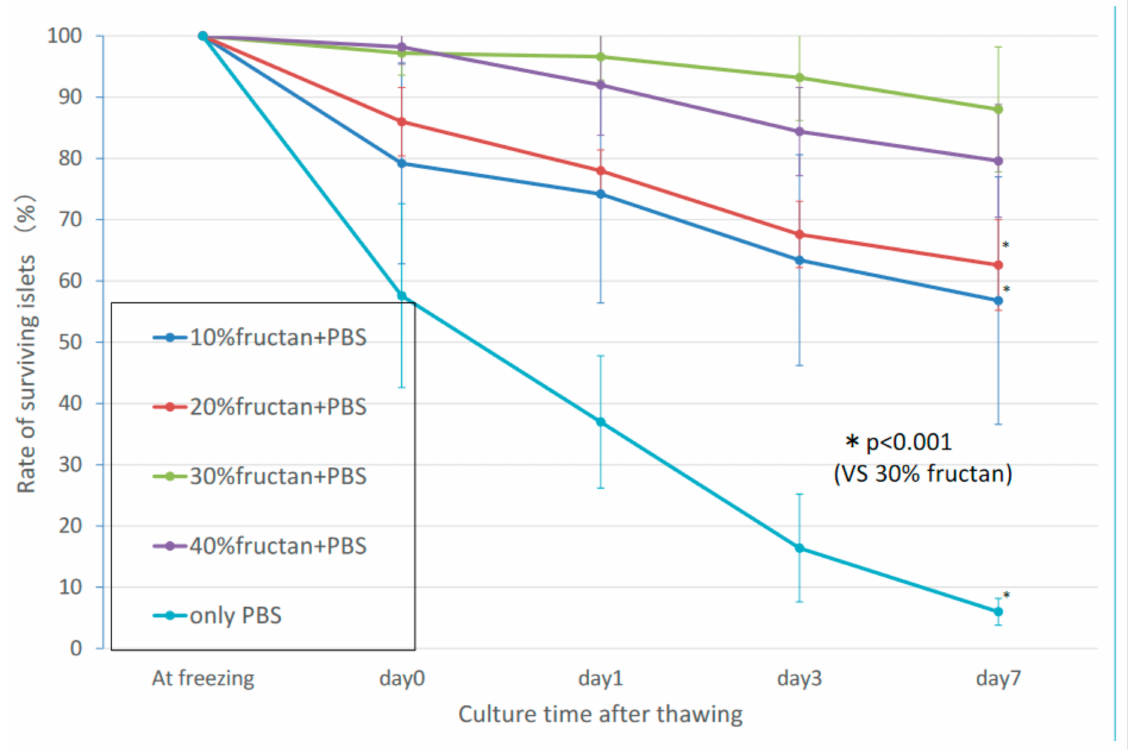
Figure 1. Number of surviving islets in the fructan groups after